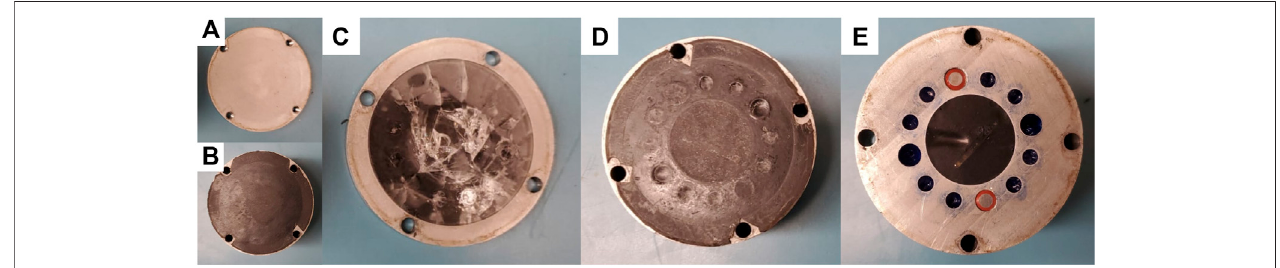
FIGURE 4 | Disassembled Test article #1 after impact. (A) Baseplate. (B) Nitrile layer between the base plate and the ring housing the glass disk. (C) Glass disk inside the aluminum ring. (D) Nitrile layer between the glass disk and the potted portion of the canister. (E) Potted MCU board at the center and two piezo actuators in their slots.